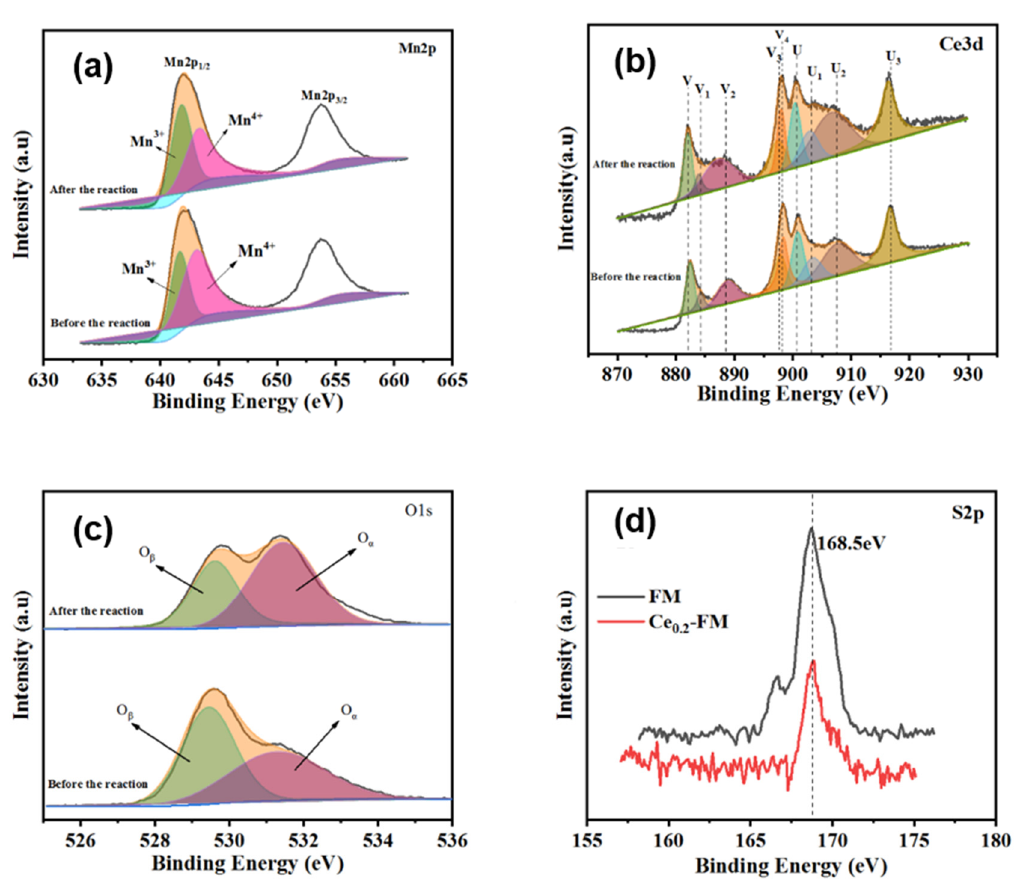
Figure 8. The XPS spectra of Ce 0.2 -MF catalyst before and after the anti-sulfur reaction: ( a ) Mn2p; ( b ) Ce3d; ( c ) O1s; ( d ) S2p spectra of the Ce 0.2 -MF and MF catalysts after the anti-sulfur reaction.